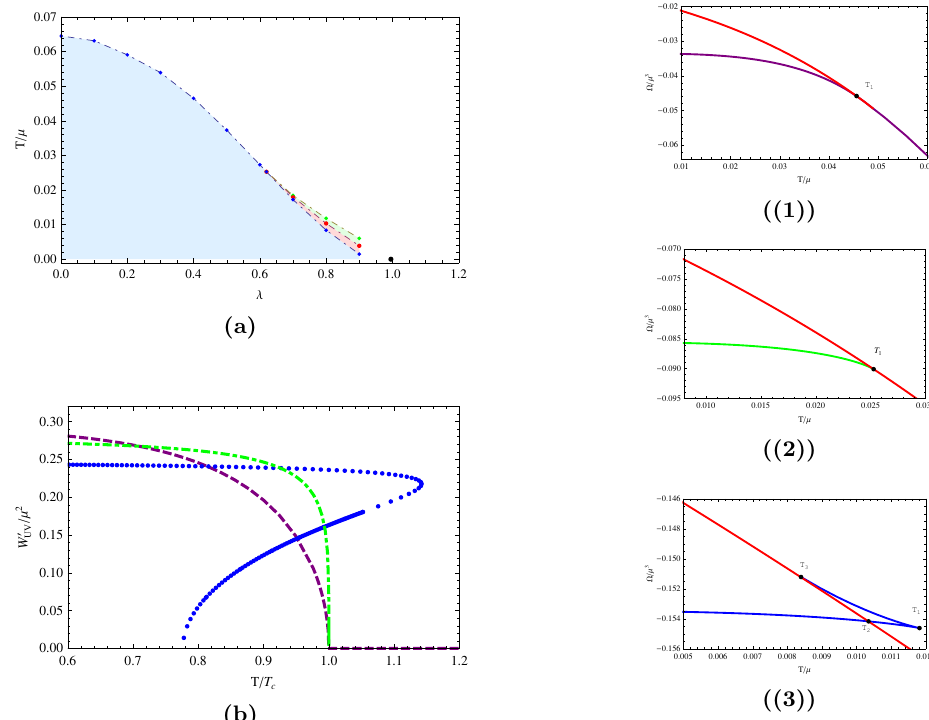
Figure 2. (a) Phase diagram of a p -wave superconductor in the (cid:21) (cid:0) T plane. The black point indicates the critical coupling (cid:21) (cid:3) at T = 0 where a quantum phase transition takes place. (b) The order parameter as a function of the temperature for three di(cid:11)erent values of (cid:21) : (cid:21) = 0 : 40 < (cid:21) c (purple), (cid:21) = 0 : 62 = (cid:21) c (green), (cid:21) = 0 : 80 > (cid:21) c (blue). (1) (2) (3) The free energy for the values of (cid:21) as in (b); the red curves are the free energies of the system in the normal